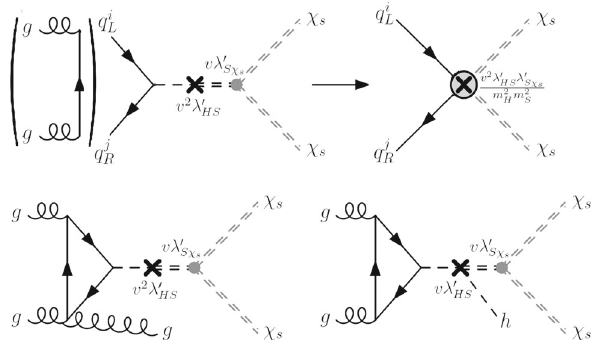
Fig. 14 Relevant diagrams contributing to nuclear interaction with scalar DM (first row) and corresponding DM observables at hadron colliders (monojet and Higgs + / E T , second row), turning on the inter- actions ∼ λ (cid:3) and ∼ λ (cid:3) HS S χ s